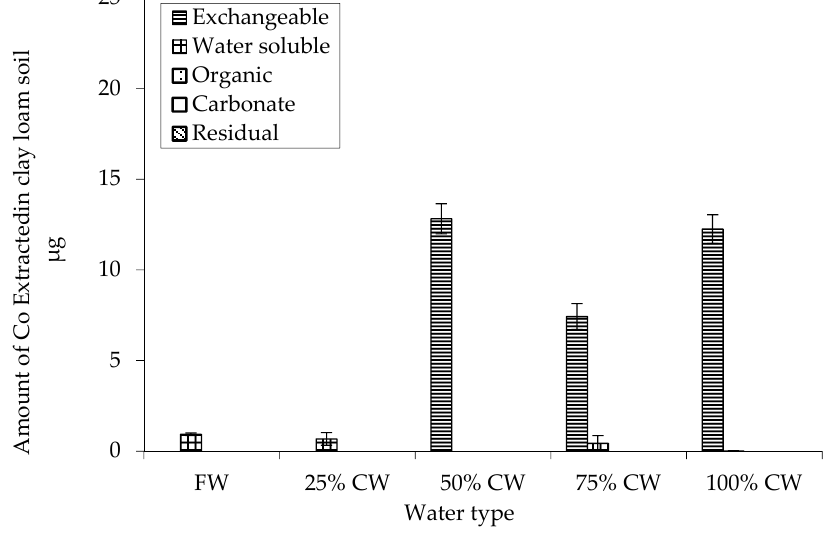
Figure 6. Mean recovered amounts of fractions of Co (in µ g) in clay loam soil that had been irrigated with different concentrations of contaminated water.